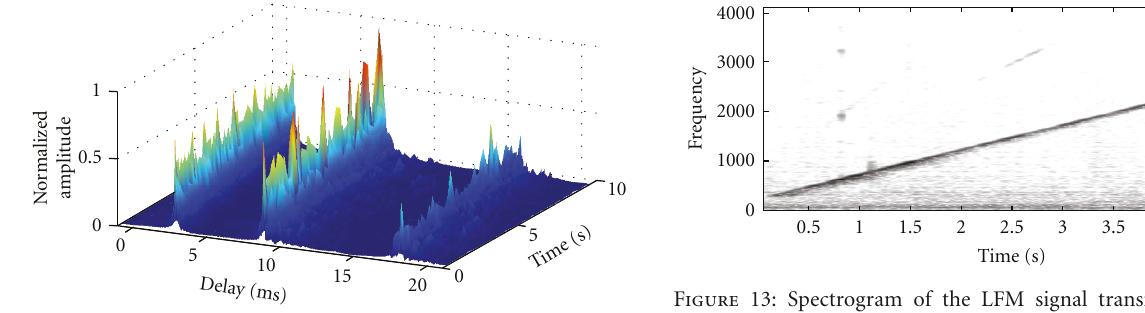
Figure 11: Three-dimensional representation of the underwater acoustic channel estimation over time, zoomed-in around the first three arrival path groups for the KAM08 experiment.